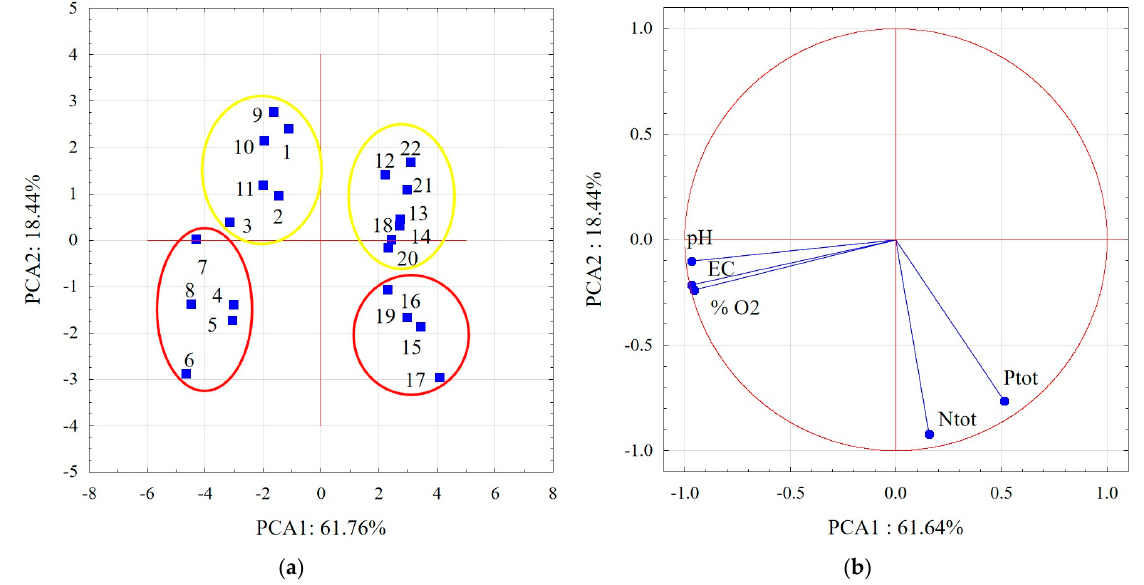
Figure 4. Results of principal component analysis for ( a ) individual measurement times at the study sites, where 1–11 and 12–22 denote successive measurements of physicochemical factors of the water at experimental sites DB and S, respectively; the color red indicates measurements made in summer; yellow denotes measurements in spring and autumn; ( b ) physicochemical parameters of the water.